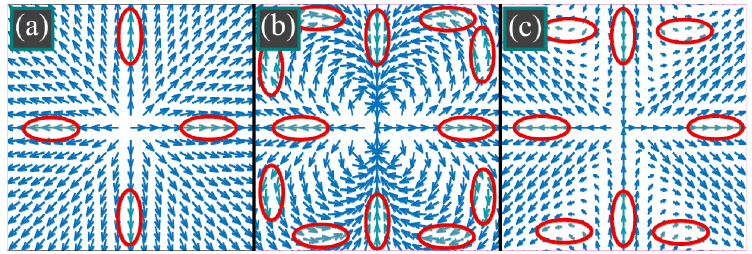
Figure 1. Conventional radial polarization ( m = n = 1) ( a ), third-order radial polarization ( m = n = 3) ( b ), double-index polarization singularity ( m = 1, n = 3) ( c ). For radial polarization ( a ), there are two angles (0 and π ) with a horizontal electric vector and two angles ( π /2 and 3 π /2) with a vertical electric vector. For 3rd-order radial polarization ( b ), there are six angles with horizontal electric vectors and six angles with vertical electric vectors. For the field with double-index polarization singularity of the order (1, 3), there are six angles with horizontal electric vectors and two angles with vertical electric